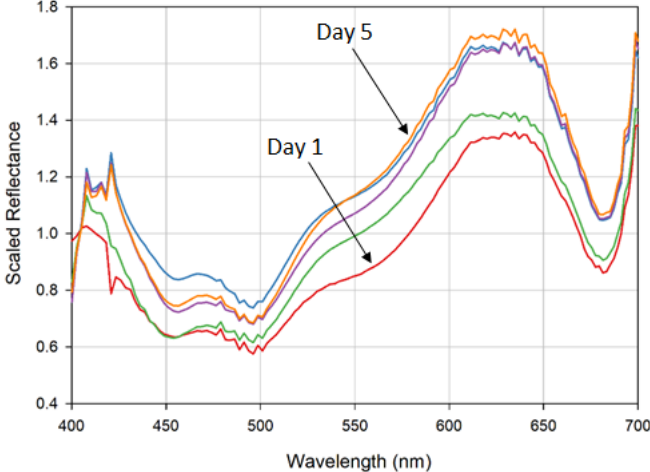
Figure 5. Spectral reflectance of a healthy apple measured over a five-day period, highlighting the changes in pigments that occur during the ripening process. Note the absorption features present at ca. 550 nm, ca. 650 nm, and ca. 675 nm. Scaled reflectance is representative of R Target in Equation (1).